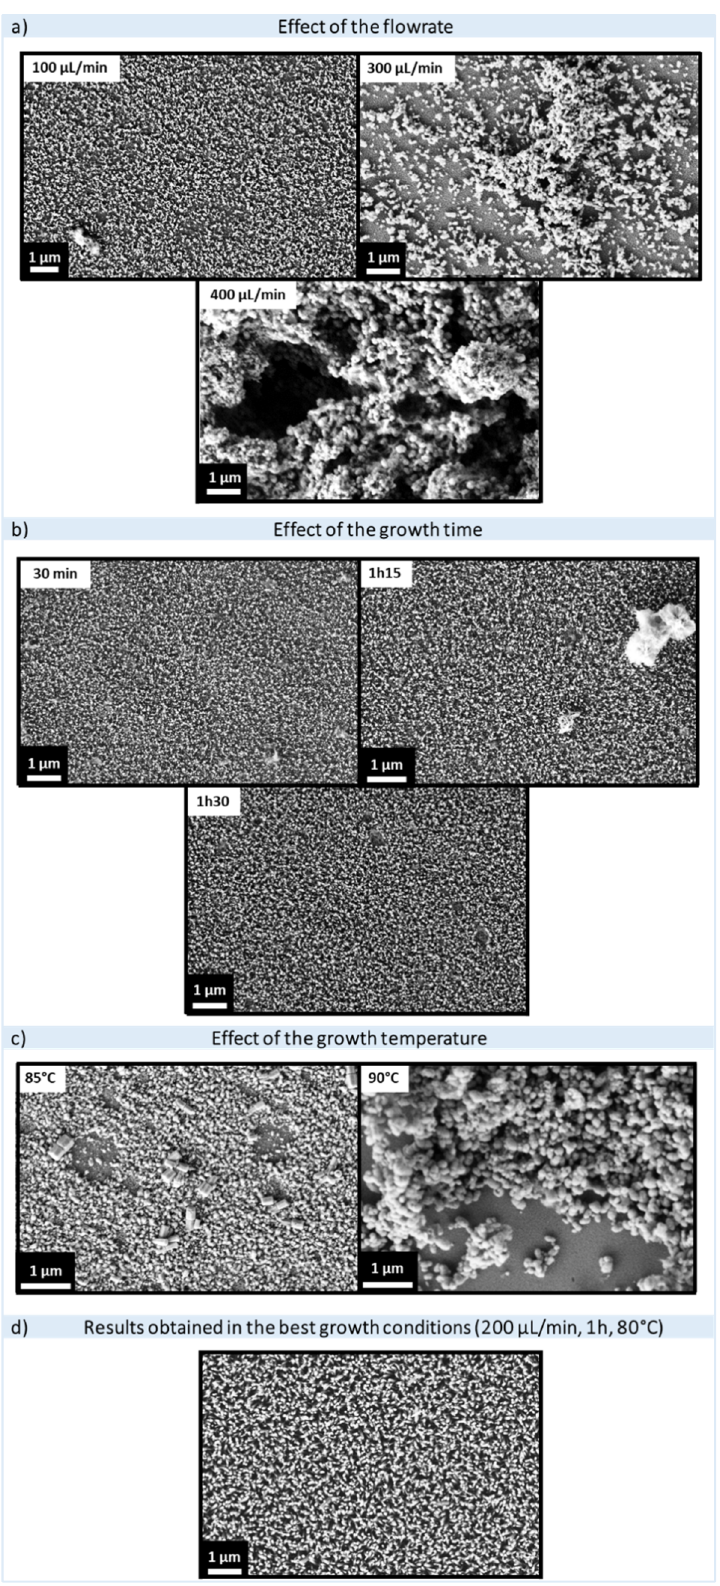
Figure 4. SEM images of the ZnO NWs obtained in the microreactor depending on the different growth conditions: effect of flowrate ( a ), effect of growth time ( b ), effect of the growth temperature ( c ) and the best growth conditions: 200 µ L/min, 1 h, 80 ◦ C ( d ) (reproduced from [30] with permission of the Royal Society of Chemistry).